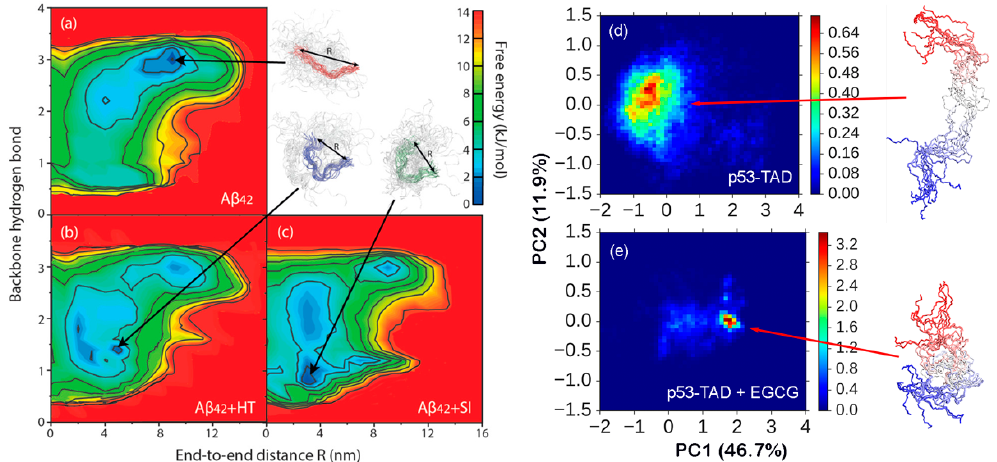
Figure 3. Conformational ensembles of A β 42 with and without the ligands ( a – c ) and p53-TAD with and without ligands ( d , e ). The conformational space of A β 42 is projected onto the number of backbone hydrogen bonds and end-to-end distance and that of p53-TAD is projected onto the first two principal components. The conformational ensembles were calculated using long timescale REST2 simulations in explicit solvent (10 and 1 µ s per replica for A β 42 and p53-TAD, respectively). Representative conformations are shown in backbone traces. This figure was adapted from [126,127]. See [126,127] for details on the simulation and